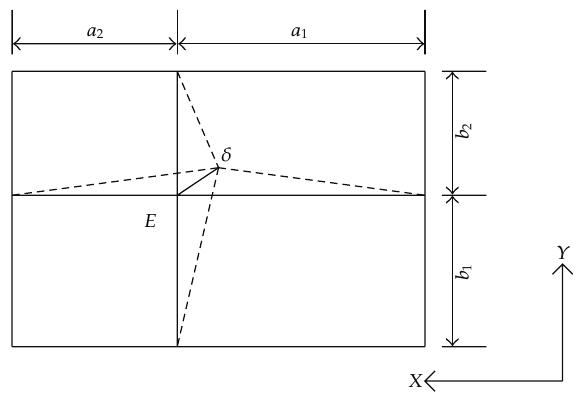
Figure 14: Displacement field assumed for SE1.